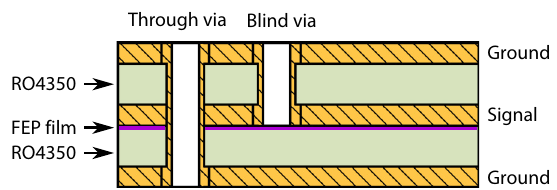
FIG. 6. Schematic diagram of the interposer stackup config- uration (not to scale). The board consists of two Rogers 4350 cores bonded by a layer of FEP film, indicated in purple. Through vias are used for grounding and shielding, whereas blind vias are utilized for signal routing to minimize parasitic